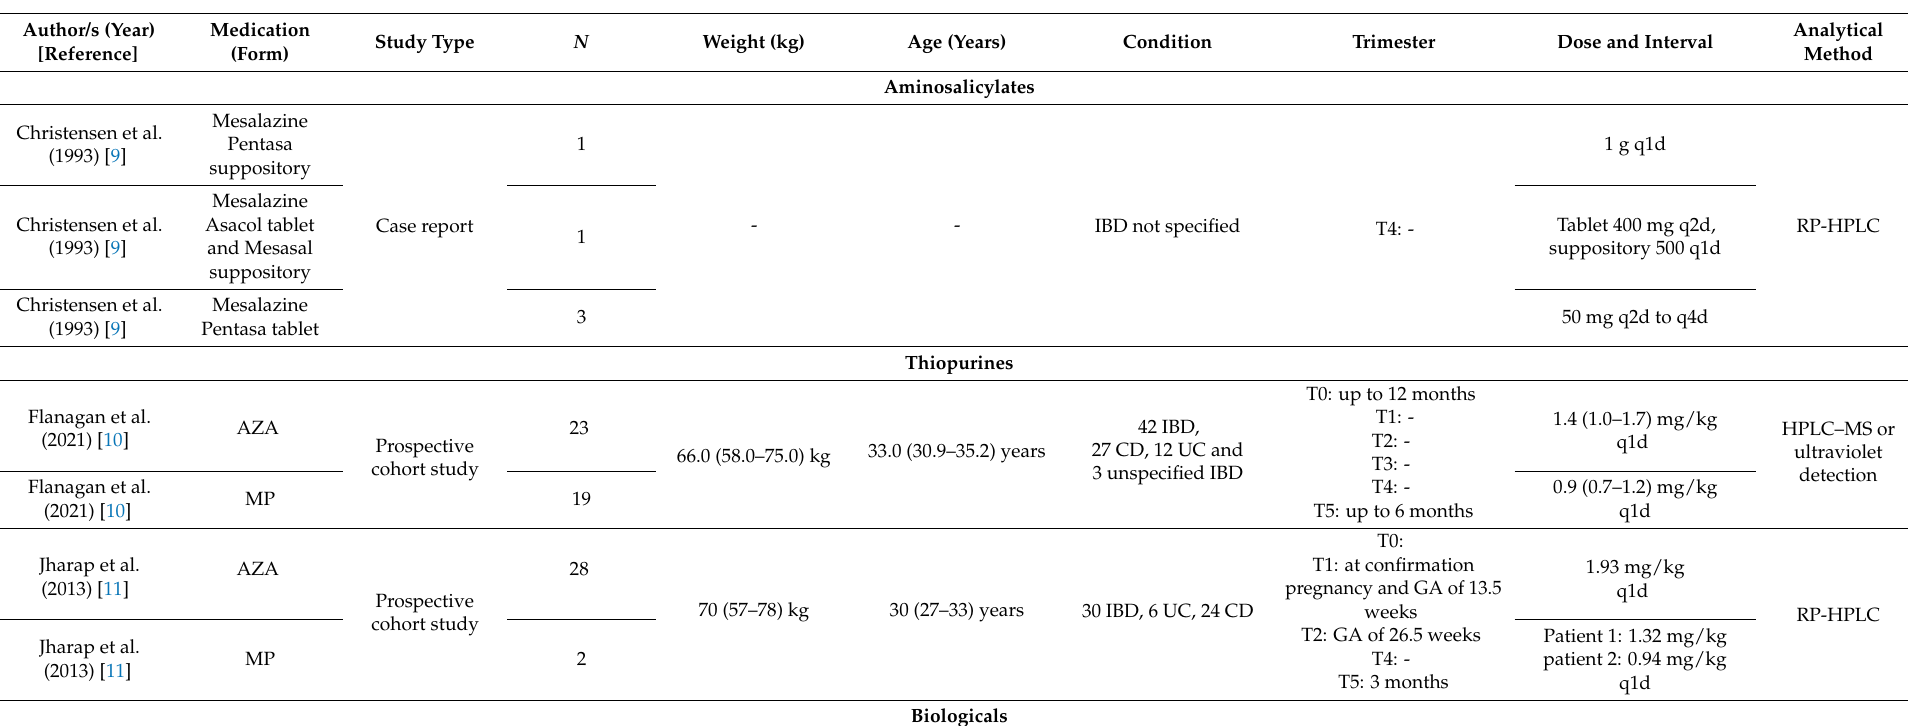
Table A2. Patient and study characteristics of the included studies in this systematic review. The data are presented as mean (SD), median (IQR) or alternative method, indicated next to the corresponding value. Each row is dedicated to one medicine. When a column overlaps multiple rows, the data are shared over multiple